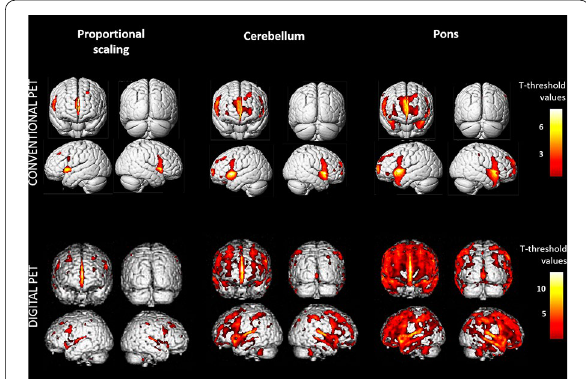
Fig. 1 Metabolic changes related to ageing with SPM linear regression analyses among the intensity normalization methods based on the whole grey-matter, the cerebellum and the pons for the conventional camera (FWE, p < 0.05, upper panel) and the digital camera (equivalent T-voxel level of the previous conventional analysis, lower panel). The results are represented with 3D-rendered